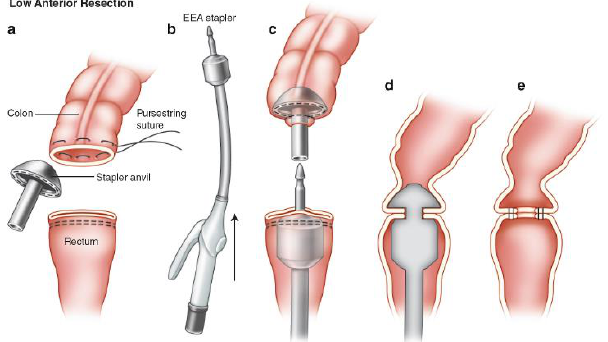
Figure 2. Schematic of an anastomosis performed with an end-to-end anastomosis (EEA) Stapler. ( a ) The stapler anvil is secured in the proximal colon with a purse string. ( b ) The EEA stapler is introduced through the anal canal and remaining rectum to the transverse rectal staple line. ( c ) The stapler spike is advanced slowly under close scrutiny of the abdominal operator and should be delivered near the midpoint of the transverse staple line. ( d ) The anvil is secured to the spike, and the stapler is closed under direct visualization. ( e ) The stapler is fired and then opened and removed per manufacturer’s instructions. Reprinted with permission from Springer International Publishing [38].